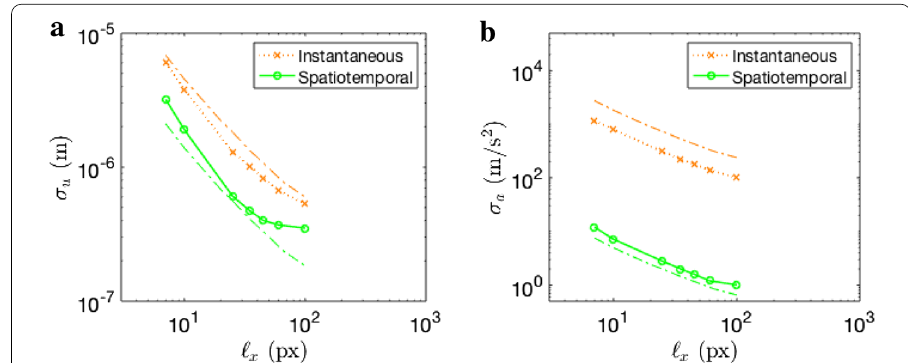
Fig. 1 Standard displacement ( a ) and acceleration ( b ) uncertainties for instantaneous and spatiotemporal analyses ( (cid:8) t = 1 ms). The physical size of one pixel is 200 µ m. The dash-dotted lines show the estimates based on the inverse DIC Hessians. The standard compromise between measurement uncertainty and spatial resolution is illustrated for both kinematic quantities. The benefit of temporal regularization is substantial for accelerations, and more limited for